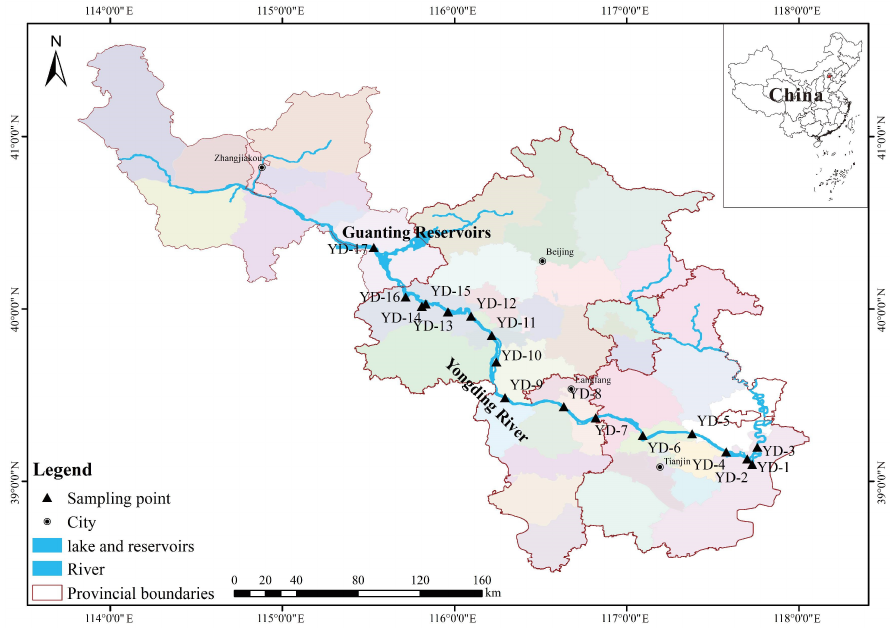
Figure 1. Sampling sites on the Yongding River.